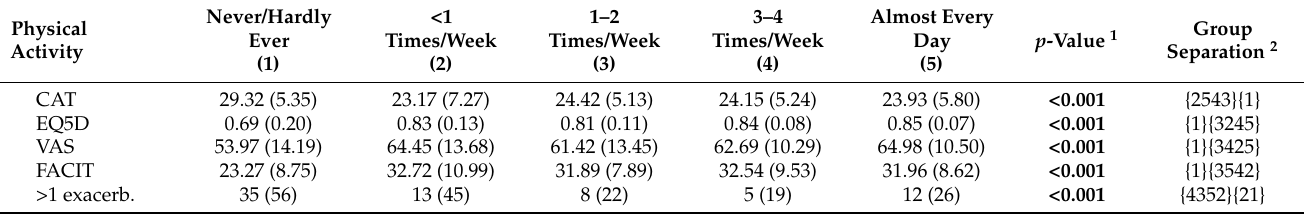
Table 2. The distribution of questionnaire scores (mean, SD) and exacerbations ( n , %) by physical activity, dog-ownership duration, and dog-walking